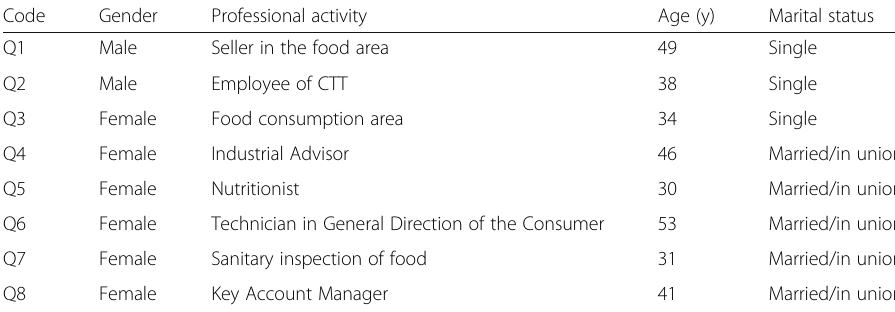
Table 2 Characterization of the participants that answered the online questionnaire Code